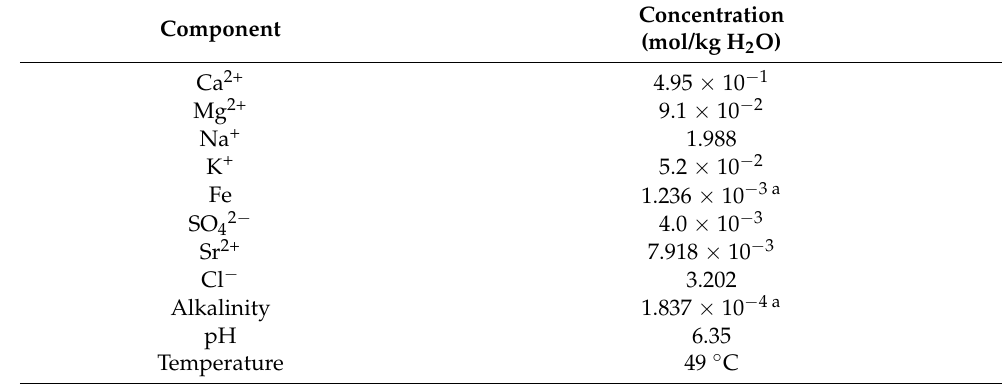
Table 4. Solution chemistry of the Mt. Simon Sandstone brine from [57].